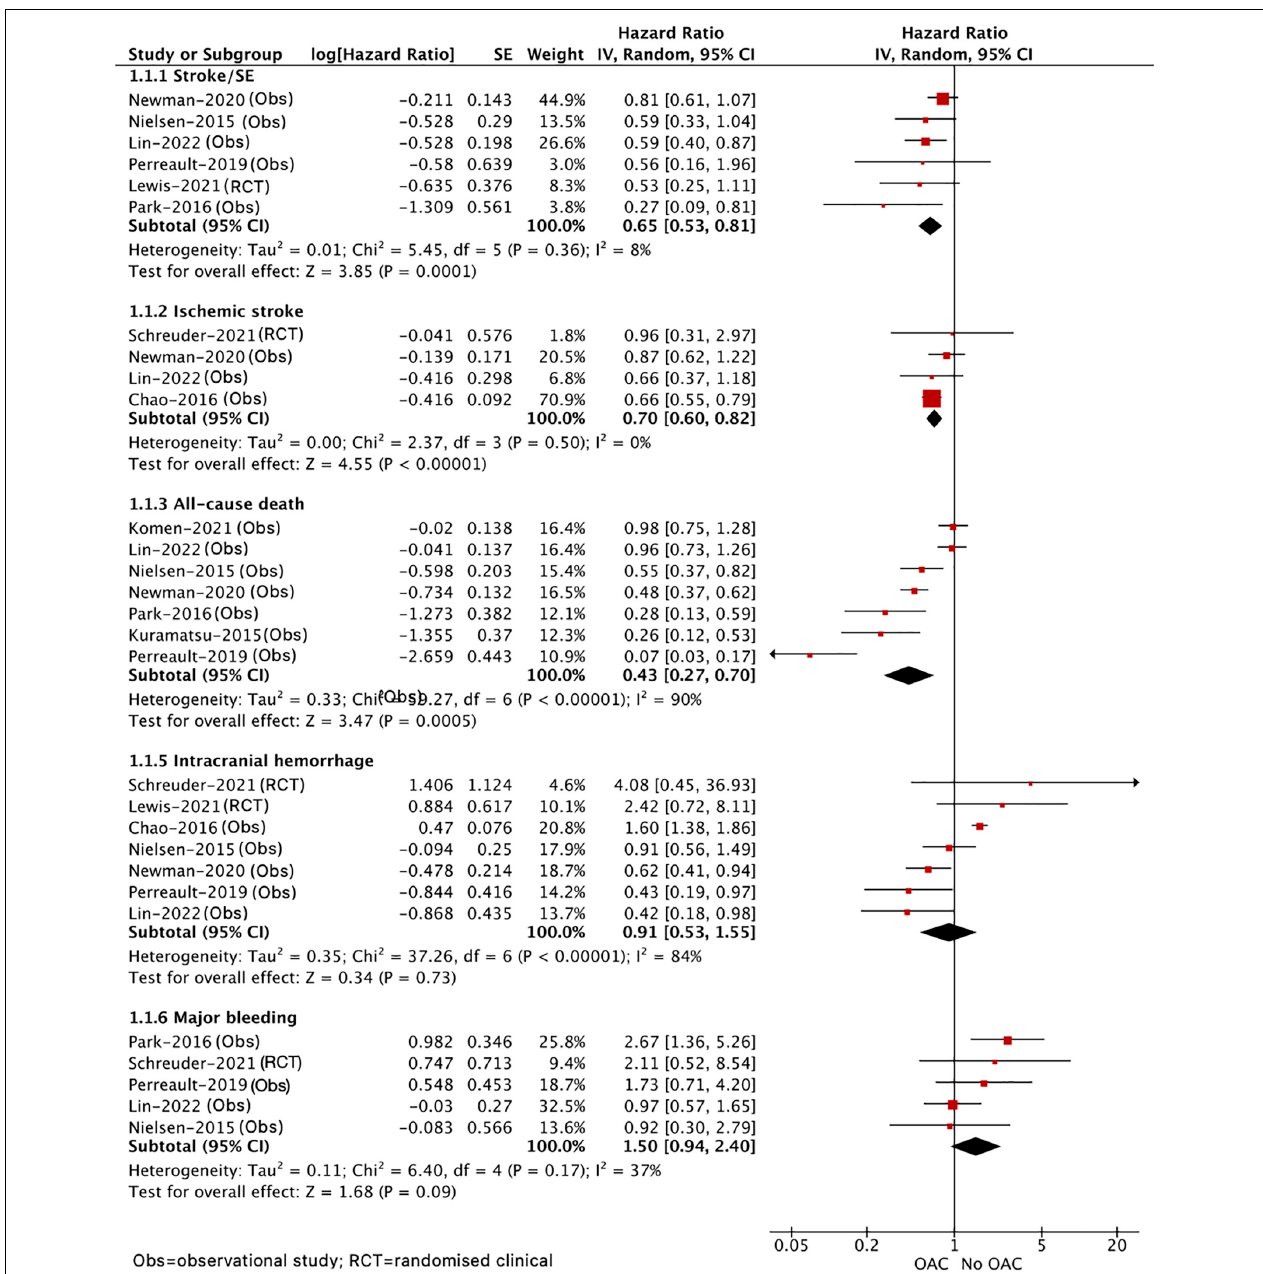
FIGURE 2 | Comparing the efficacy of OAC with no OAC in patients with AF after ICH. AF, atrial fibrillation; ICH, intracranial hemorrhage; OAC, oral anticoagulants; CI, confidence interval; IV, the inverse of the variance; SE, standard error; and SE, systemic embolism.